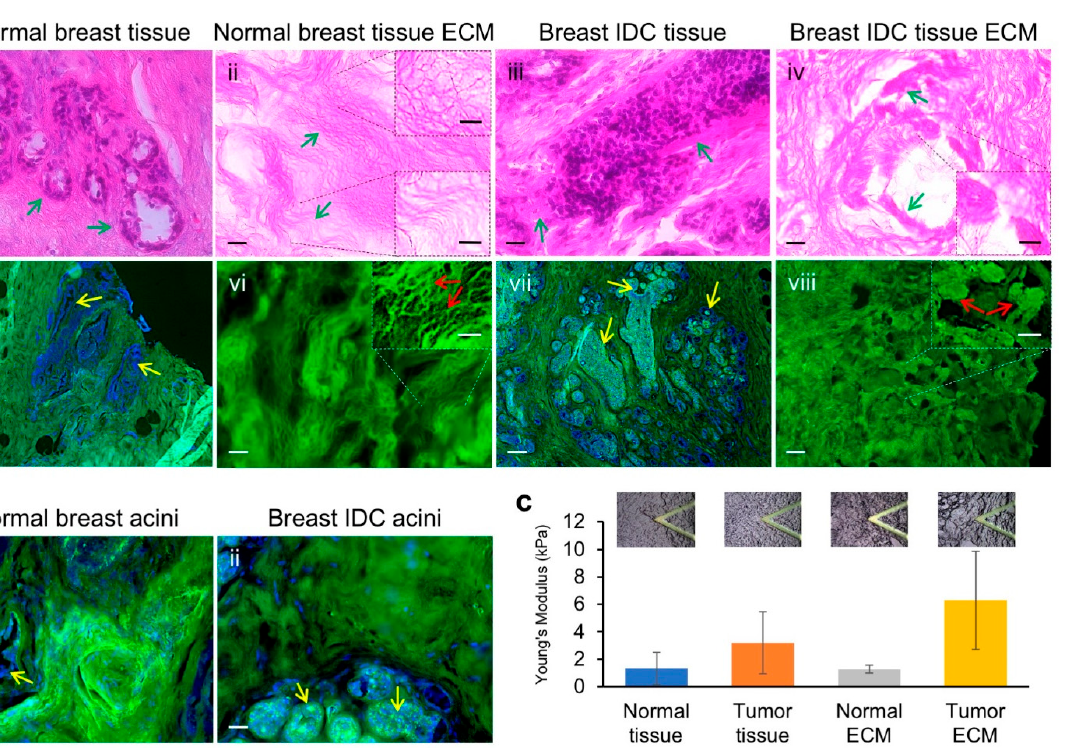
Figure 1. Histopathological features of normal and invasive ductal carcinoma tissues and ECM. ( a ) H&E staining (upper panels) of the cross sections of the normal breast tissue ( i ), decellularized normal breast tissue ECM ( ii ), breast IDC tissue ( iii ), and decellularized breast IDC tissue ECM ( iv ) as well as IF staining (bottom panels) of the corresponding tissue or ECM sections ( v – viii ). Green stain, Col I; blue stain (Hoechst), nuclei; white stain, Ki-67. Arrows indicate the normal or cancerous acini or ECM structures. Insets magnify the indicated regions of interest. Scale bars: ( i – iv , vi , viii ), 20 µ m; ( ii , iv ) insets, 10 µ m; ( v , vii ), 100 µ m; ( vi , viii ) insets, 50 µ m. ( b ) High magnification of IF images showing the acinar structures void of Col I staining of the breast epithelial cells (yellow arrows) in normal breast tissues ( i ) and positive for the infiltrated cancer cells (yellow arrows) within the acini lumens in IDC tissues ( ii ). Green stain, Col I; blue stain (Hoechst), nuclei; white stain, Ki-67. Scale bars: ( i , ii ), 20 µ m. ( c ) Graphed Young’s modulus values for the elasticities of the tissues or ECM measured with AFM. A minimum of seven measuring spots on three consecutive cross sections of each sample were used for data acquisition. Representative microscopic images of tip-probing status were exhibited on top of the values of the individual samples. Error bars, standard deviation